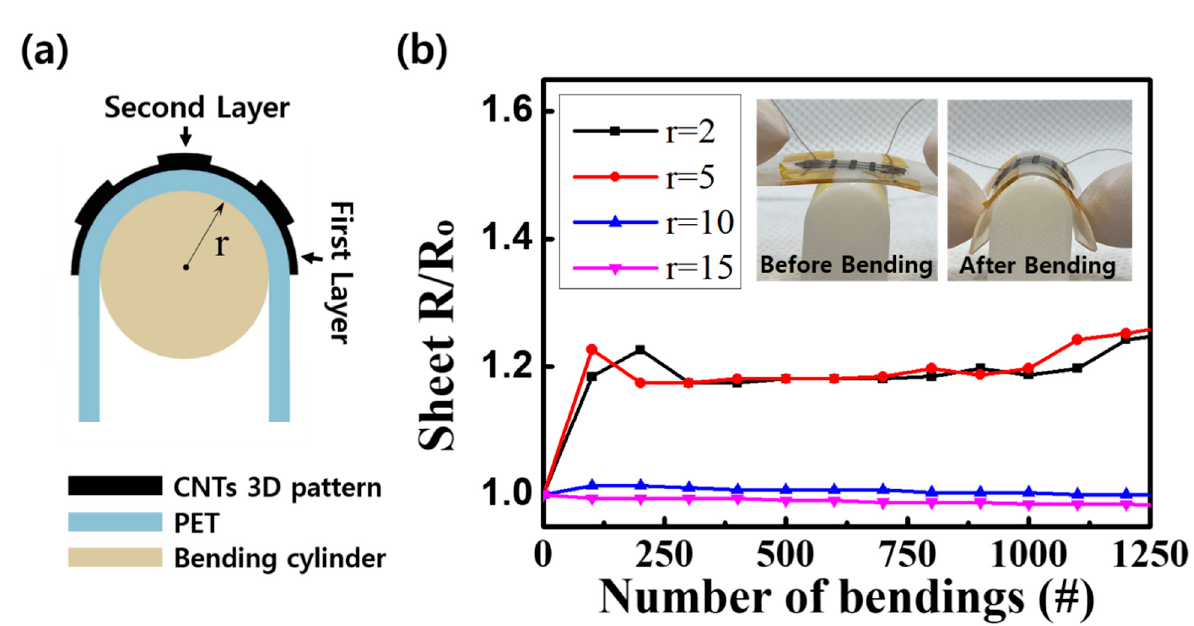
Figure 5. ( a ) Conceptual illustration of bending experiments applied to a CNT 3D pattern on the PET substrate. ( b ) Changes in the ratio of electrical sheet resistance to the initial resistance according to the number of bending experiments. An inset image shows the 3D pattern on the bending cylinder.